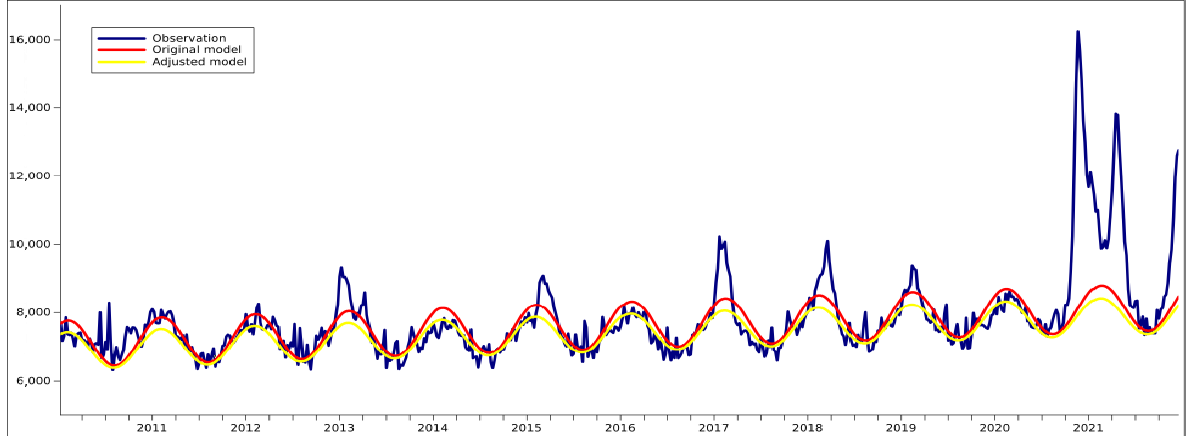
Figure 1. Number of weekly deaths based on reported data, with the explanatory model by Verbeeck et al. and its adjusted version. Dataset from 2010-W01 to 2021-W48; data source: Statistics Poland.